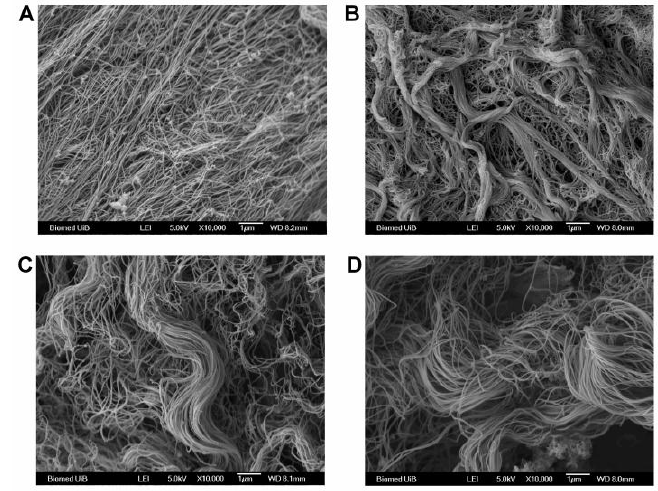
Figure 8. A representative scanning electron micrograph of collagen in 4T1 tumors ( n = 6) from WT ( A ) and β3-KO mice ( B ) and RM11 tumors ( n = 4) from WT ( C ) and β3-KO mice ( D ), respectively. Scale bars indicate 1 µm.